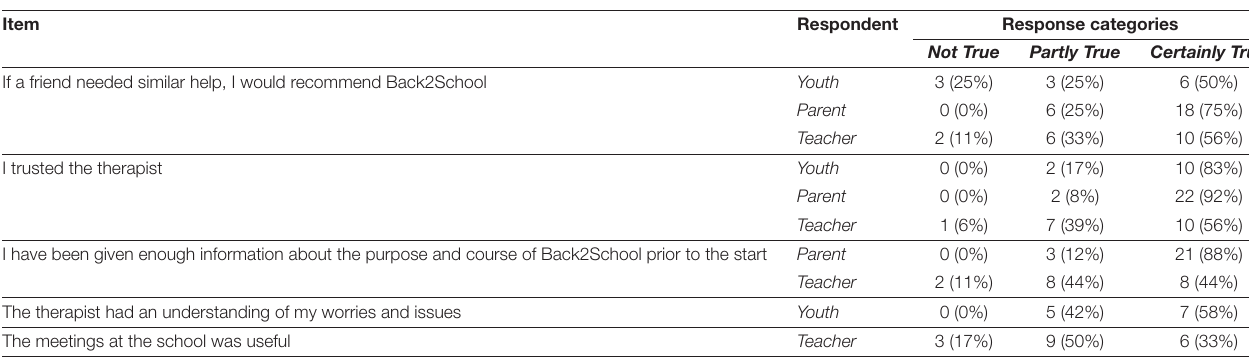
TABLE 4 | Intervention Satisfaction at post-intervention.